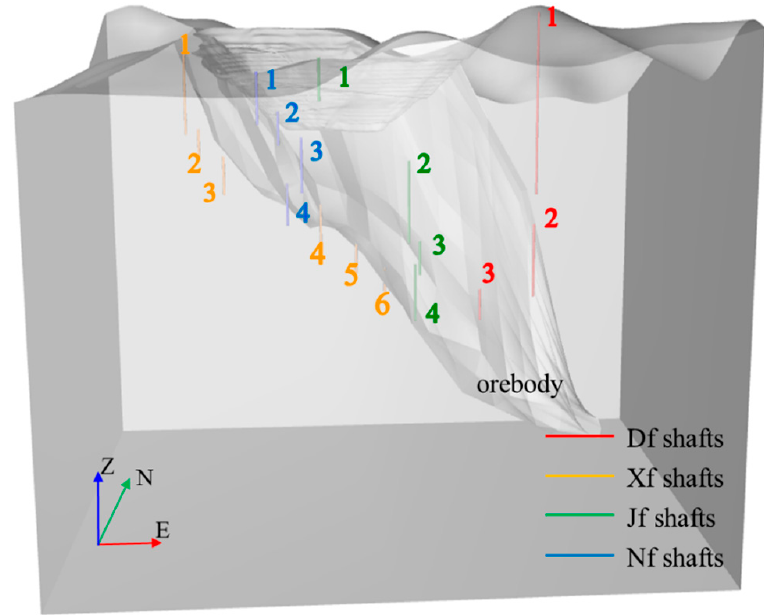
Figure 3. Distribution of the underground development system.